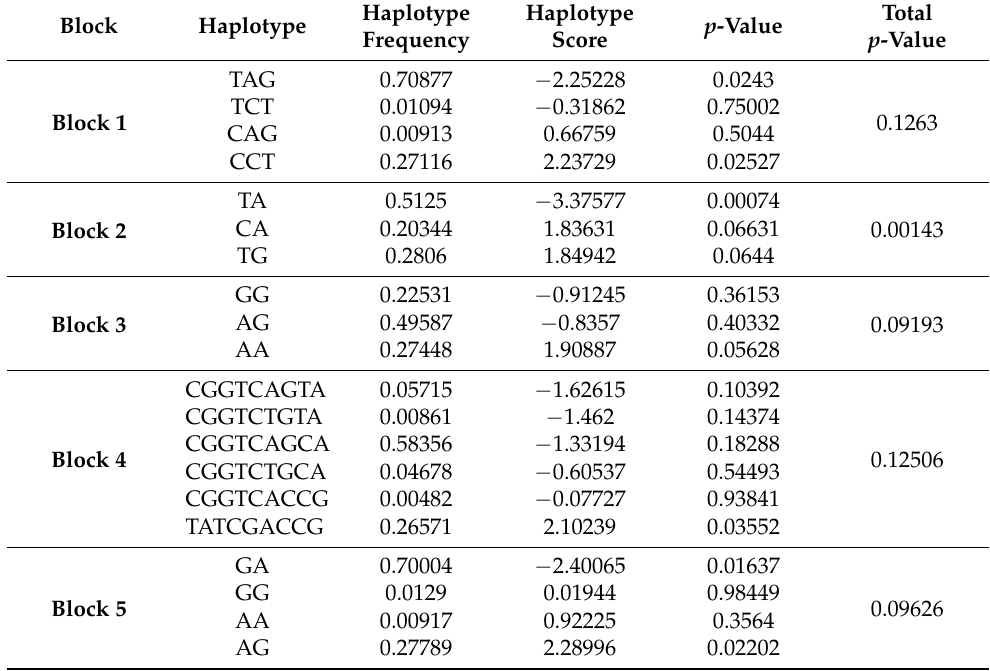
Table 4. Correlation analysis between haplotype of GLIPR1 promoter and backfat